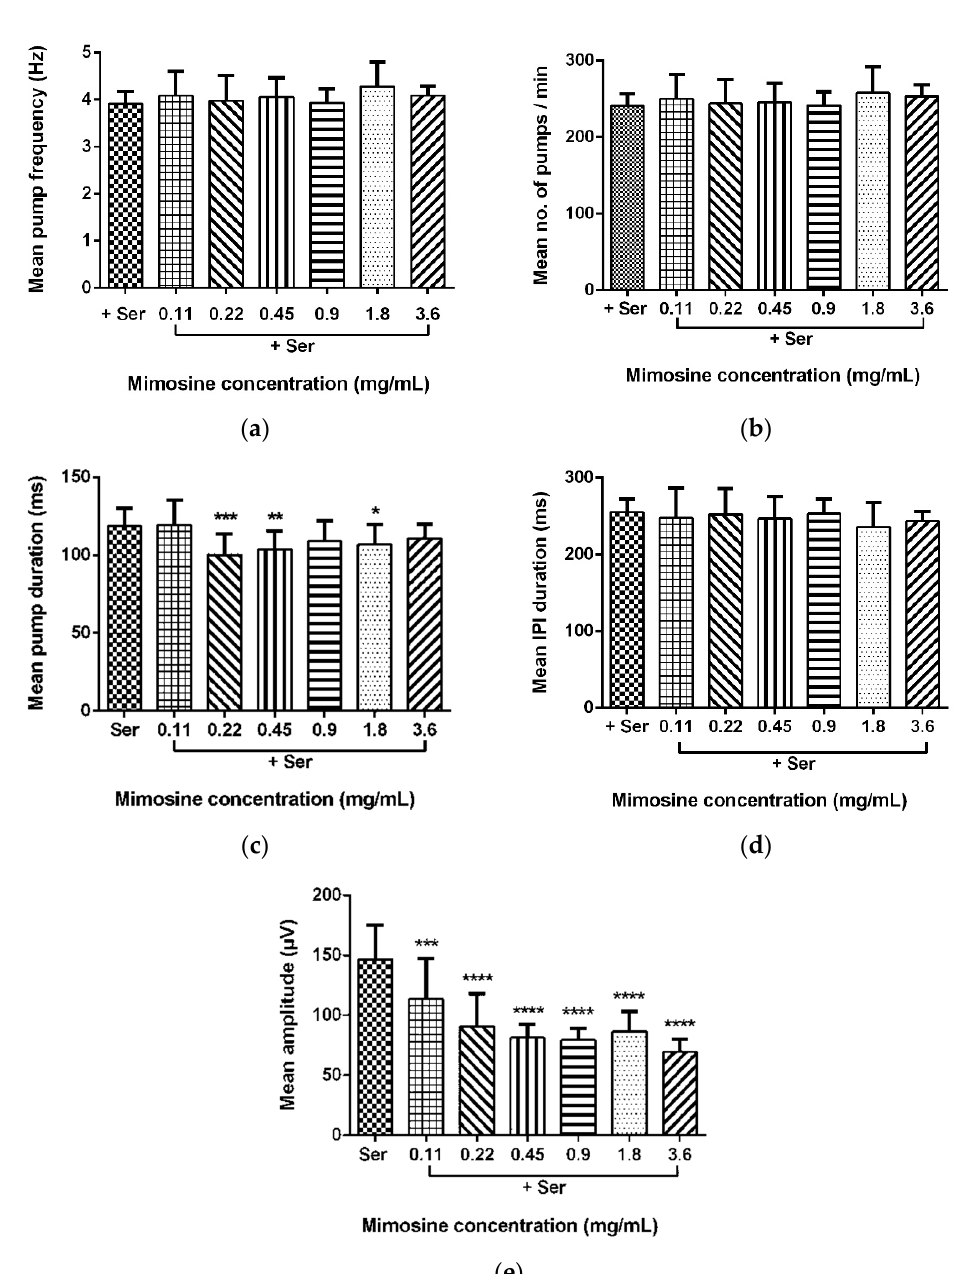
Figure 9. Effect of mimosine on pharyngeal pumping activity. ( a ) Mean pump frequency. ( b ) Mean number of pumps. ( c ) Mean pump duration. ( d ) Mean inter-pump interval (IPI) duration. ( e ) Mean pump amplitude. Data are presented as means ± SD and are compared to Ser as the standard pumping stimulus. Statistical significance was calculated using a two-way ANOVA with Dunnett’s multiple comparison test and is denoted by asterisks. * p ≤ 0.05; ** p ≤ 0.01; *** p ≤ 0.001; **** p ≤ 0.0001. n = 15 worms.